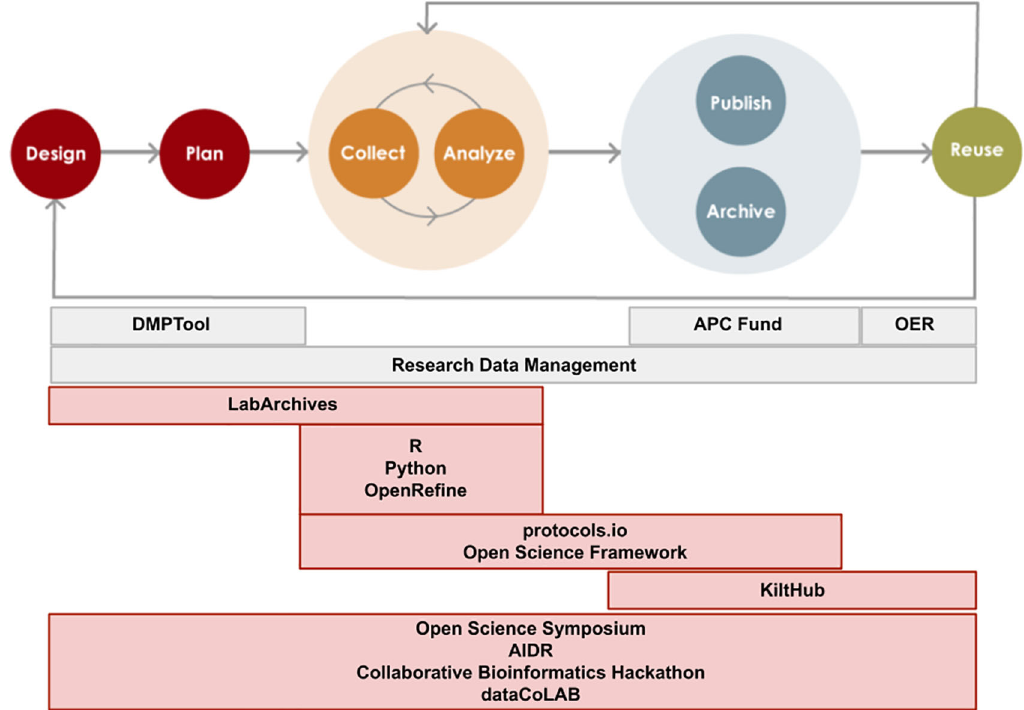
Figure 1. Open Science tools and services mapped to the research life cycle. Tools and services that OSDC supports with consultations, training opportunities, or licenses are mapped onto the phases of the research life cycle. Services and tools in gray boxes are supported by colleagues in the University Libraries that specialize in Open Access, Research Data Management, and Open Educational Resources. DMPTool: on online application that helps create Data Management Plans that meet funder mandates; OER: Open Educational Resources; APC: Article Processing Charge; OpenRefine: an open source digital tool for data cleaning and wrangling; KiltHub: CMU ’ s institutional repository; AIDR: Artificial Intelligence for Data Discovery and Reuse Conference; dataCoLAB: Data Collaborations Lab, an initiative to foster partnerships on data science projects on real-world research